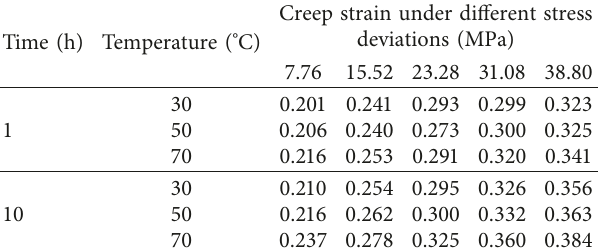
Figure 4: Influence of different temperatures on creep properties of shale. (a) Strain-time curves ( T 70 ° C). (c) Isochronous stress deviation-strain curves ( T Table 4: Creep strains of shale under different stress levels and temperatures (unit: %). Time (h) Temperature ( °